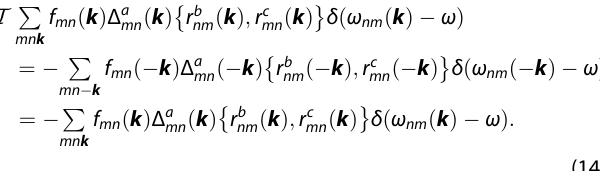
; r c f r b g δ ω nm (cid:2) ω ð Þ between top mn nm mn